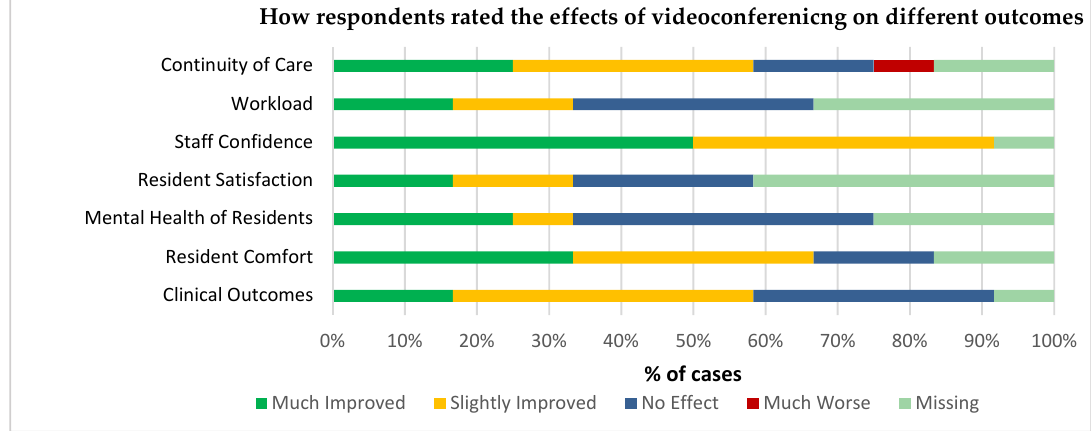
Figure 4. Breakdown of how respondents rated the effect of videoconferencing on outcomes.